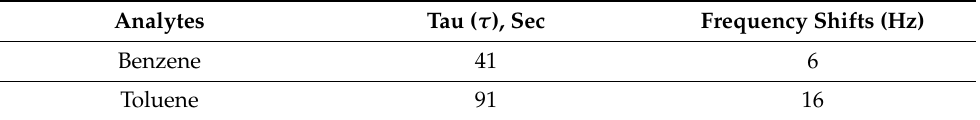
in PEMA-DIOA (10%)